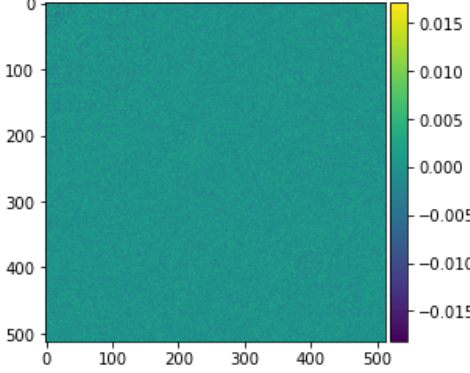
Figure 5. A 2D visualization of matrix Π .